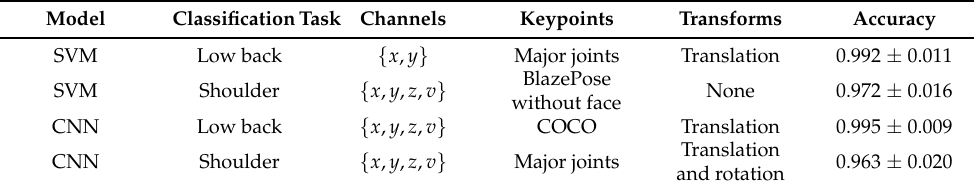
Table 1. The optimized models used for subsequent experiments. For each model (CNN and SVM) and each classification task (low back and shoulder), a grid search was performed to select the optimal input channels, keypoint set, and coordinate transforms. All models used a window width of 16 s and a sampling rate of 25 Hz. Model accuracies in a 5-fold cross validation experiment, split by subject, using videos from only one camera angle per exercise are shown below. Model Classification Task Channels Keypoints Transforms SVM { x , y } Major